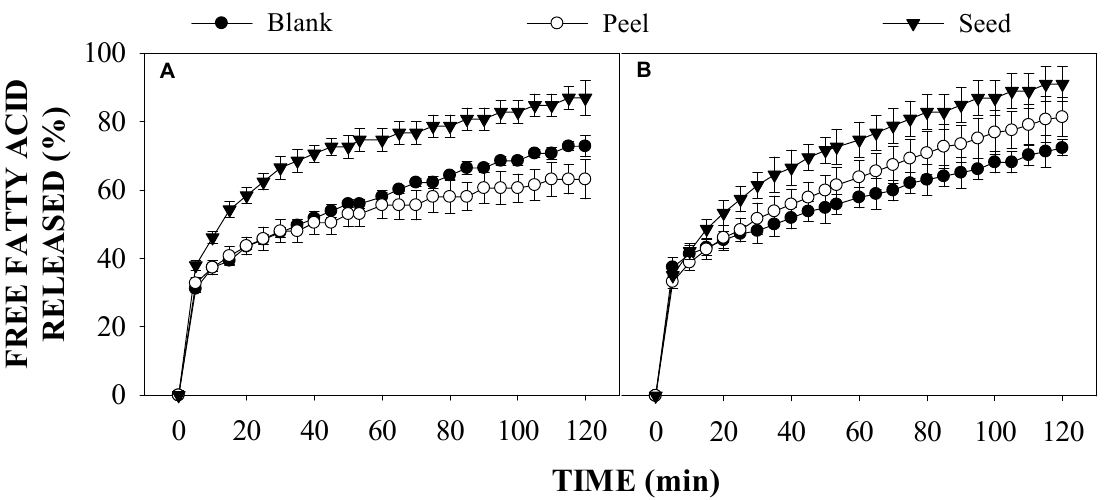
Figure 4. Effect of low methoxyl pectin (LMP) on the free fatty acid release in oil-in-water (O/W) emulsions containing avocado peel and seed extracts. ( A ) = O/W dispersions; ( B ) = Emulsions containing LMP.